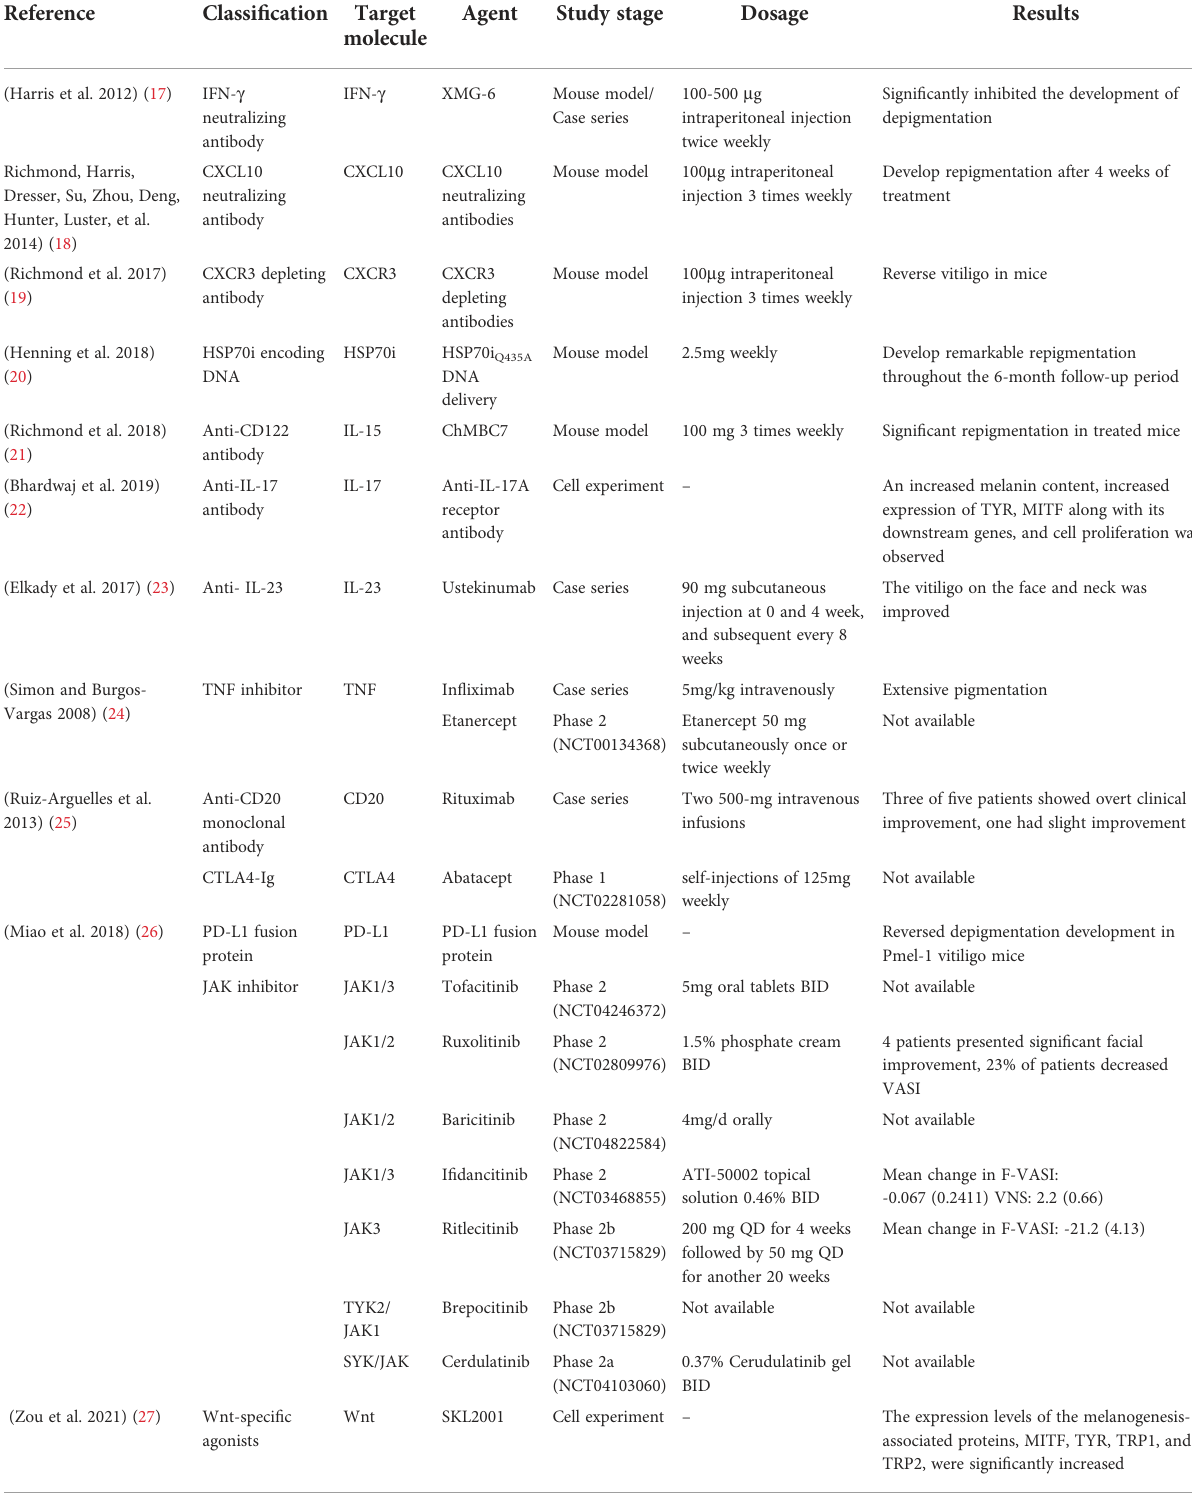
HLA, human leukocyte antigen; TCR, T cell receptor; DAMPs, damage-associated molecular patterns; TRM, resident memory T cells; JAK, Janus kinase; STAT, signal transducer and activation of transcription; CXCL, chemokine (C-X-C motif) ligand; CXCR, chemokine (C-X-C motif) receptor; TNF, tumor necrosis factor; F-VASI, Facial Vitiligo Area Scoring Index; VNS, Vitiligo Noticeability